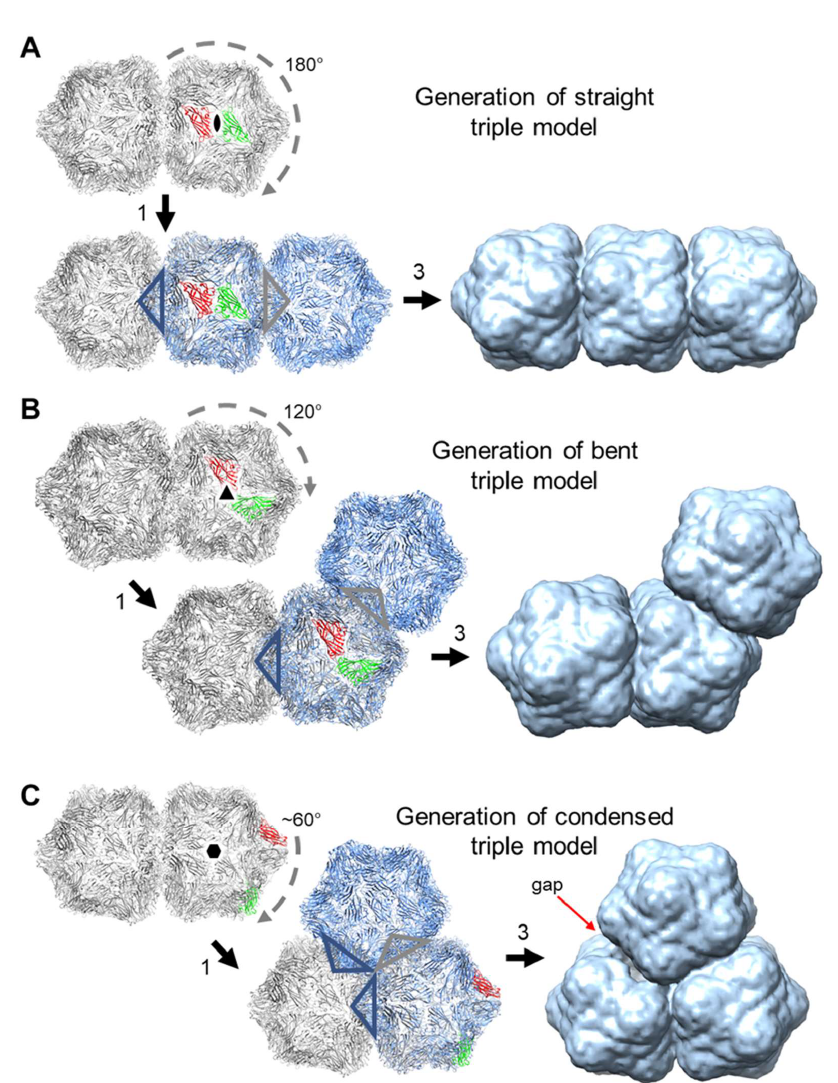
Figure 8. Hypothetical 3-D models of the three morphologies of geminate triples were generated from the previously determined 3.3-Å resolution ageratum yellow vein geminivirus structure (PDB accession code 6F2S; [38]). In each case, the model was created from two copies (distinguished by grey and blue colouration, respectively) of the geminate double structure by superposition based on symmetry-related subunits. Specifically: 1. the red subunit of one copy was aligned with the green subunit of the other copy using UCSF Chimera [51], 2. the two models were merged and one copy of every overlapped pair of subunits was removed as well as all the subunits from the five-fold vertices that were projecting into adjoining partial capsids (the latter are indicated by the colour-coded open triangles; step not explicitly shown in Figure), 3. the resultant models were subsequently rendered as molecular surfaces (not 3-D volumes) at 15 Å resolution to resemble low resolution electron microscope (EM) reconstructions. ( A ), For the straight triple model, the superposition of two-fold related subunits resulted in a 180° rotation of the second copy. ( B ), For the bent triple model, the superposition of three-fold related subunits resulted in a 120° rotation of the second copy. ( C ), For the condensed triple model, the superposition of approximately six-fold related subunits resulted in a ~60° rotation of the second copy. This gave a roughly three-fold symmetric molecular surface with a small gap between two of the partial capsids. By contrast, the corresponding 2-D class average appears to be exactly three-fold symmetric (see Figure